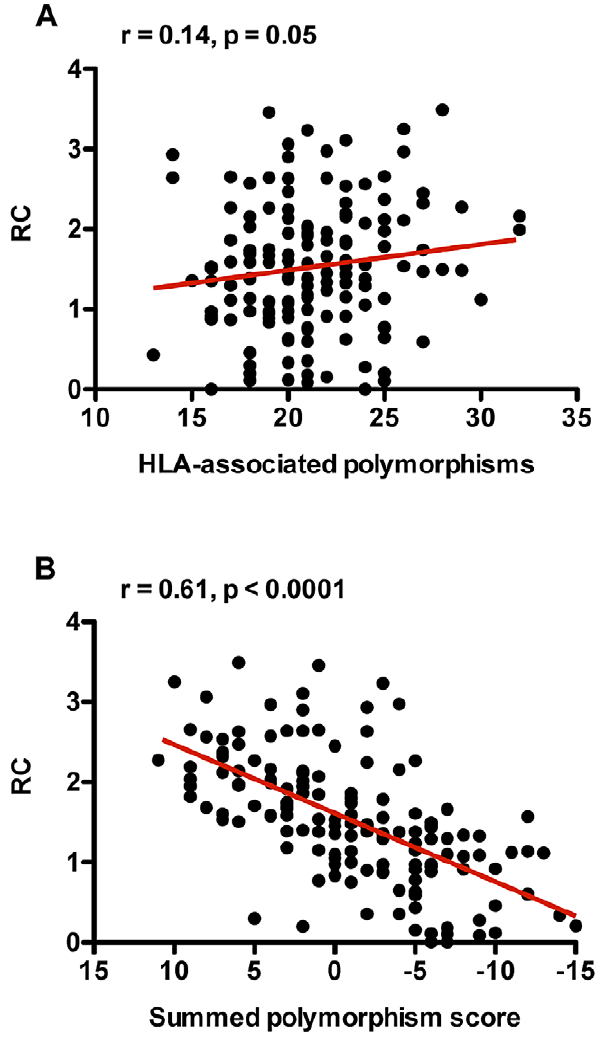
Figure 5. The balance of fitness increasing and decreasing HLA-associated polymorphisms strongly correlates with RC. (A) The total number of HLA-associated polymorphisms positively corre- lates with RC. HLA-associated polymorphisms were defined as non- consensus residues at any amino acid position known to have polymorphisms statistically linked to HLA-I alleles. (B) RC of Gag-MJ4 chimeras is highly correlated to the summed polymorphism score in Gag. Each amino acid polymorphism was given a score of 1 (fitness increasing) or 2 1 (fitness decreasing). Summed polymorphism scores were generated by summing these scores for each Gag protein. Trend lines were generated using linear regression analysis, and are shown in order to facilitate visualization of